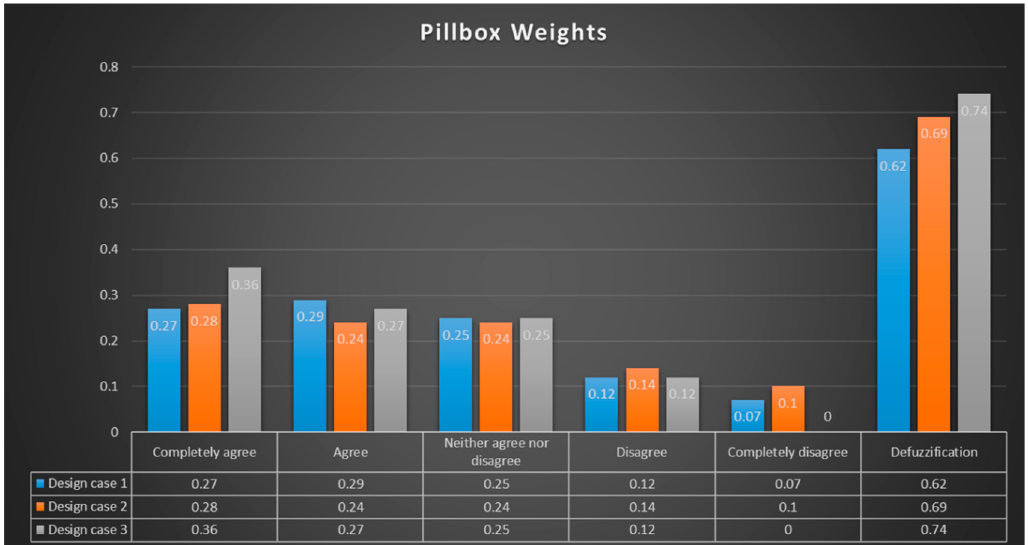
Figure 3. Subjects’ satisfaction degree and defuzzification values for the three design cases. satisfaction degree value, the highest score of each program.